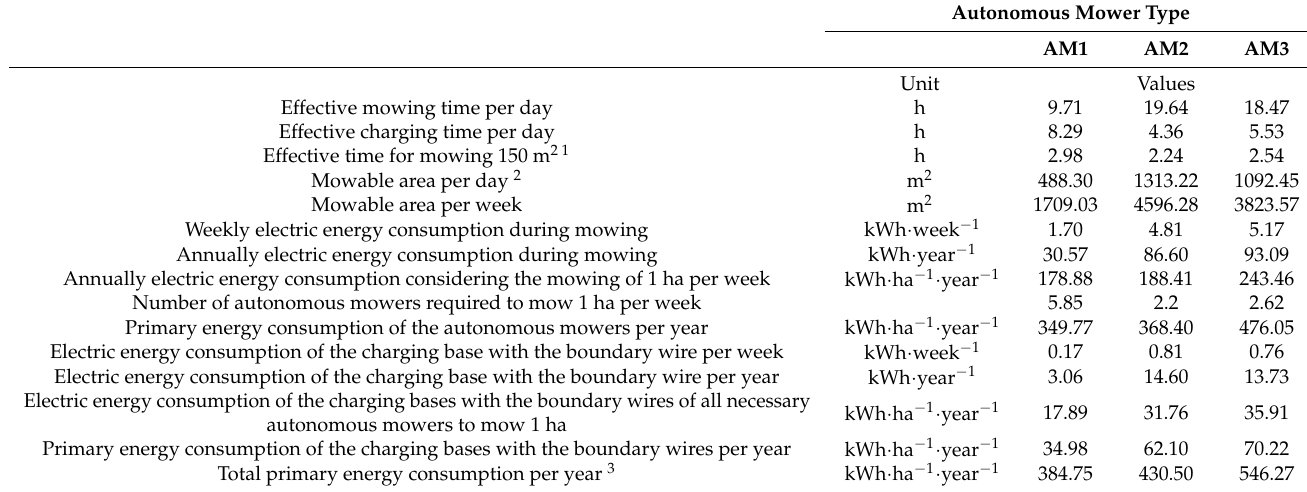
Table 4. Estimated energy consumption values for each type of autonomous mower according to the chosen work